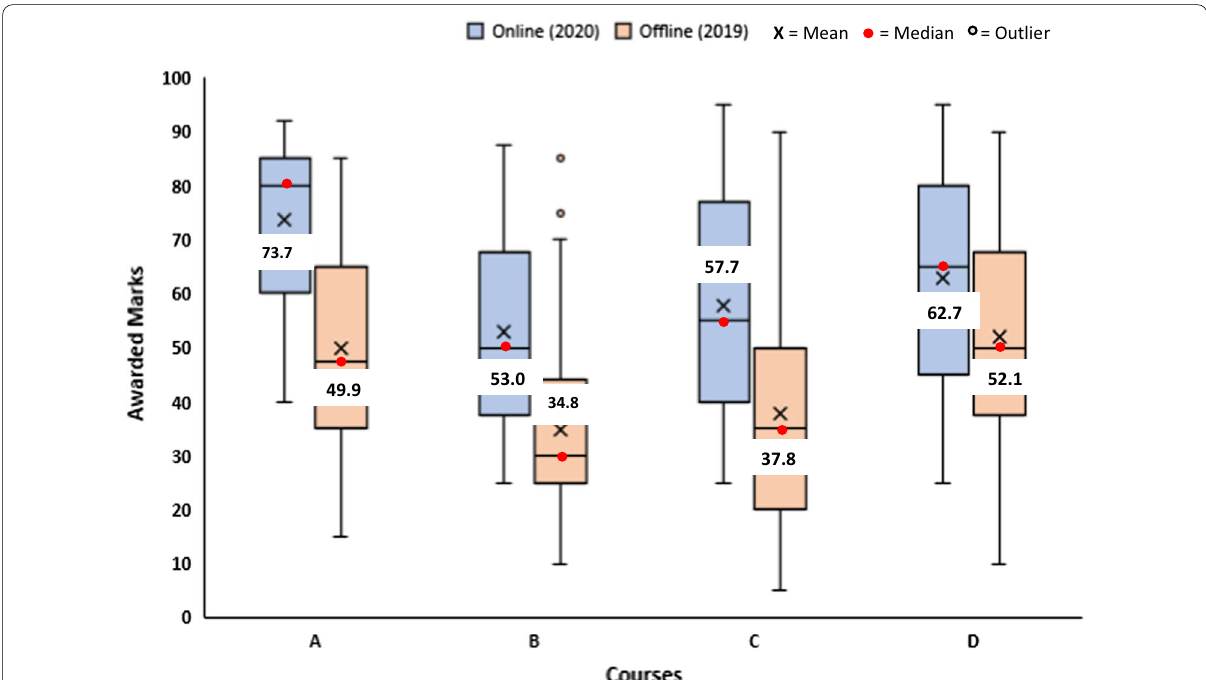
Fig. 3 Box plot comparing marks of four courses chosen randomly from 2019 and 2020 academic sessions (no. of students per course Awarded marks in 2019 (orange colour) represent assessment done with the traditional face-to-face method (offline), while awarded marks in 2020 (blue colour) represent assessment during the COVID-19 lockdown (online). In each box, the horizontal border represents the first and third quartiles of awarded marks, upper and lower whiskers represent the highest and lowest awarded marks for each cohort, and interquartile range (IQR) rule was used to identify outliers. The awarded marks for all courses in 2020 were found to be significantly different ( p < 0.05) from awarded marks in 2019 using an unpaired two-tailed unequal variance t